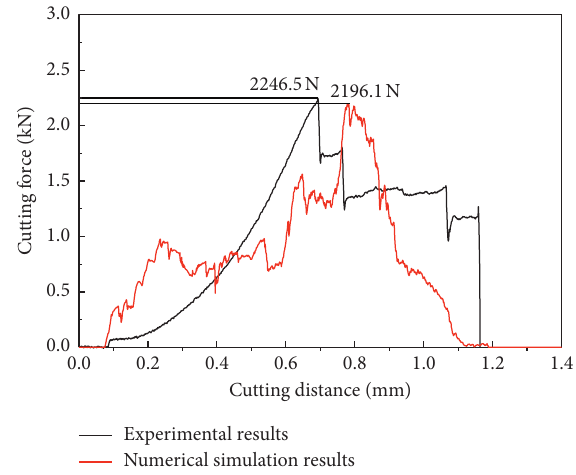
Figure 4: The cutting force of experimental and numerical simulation.